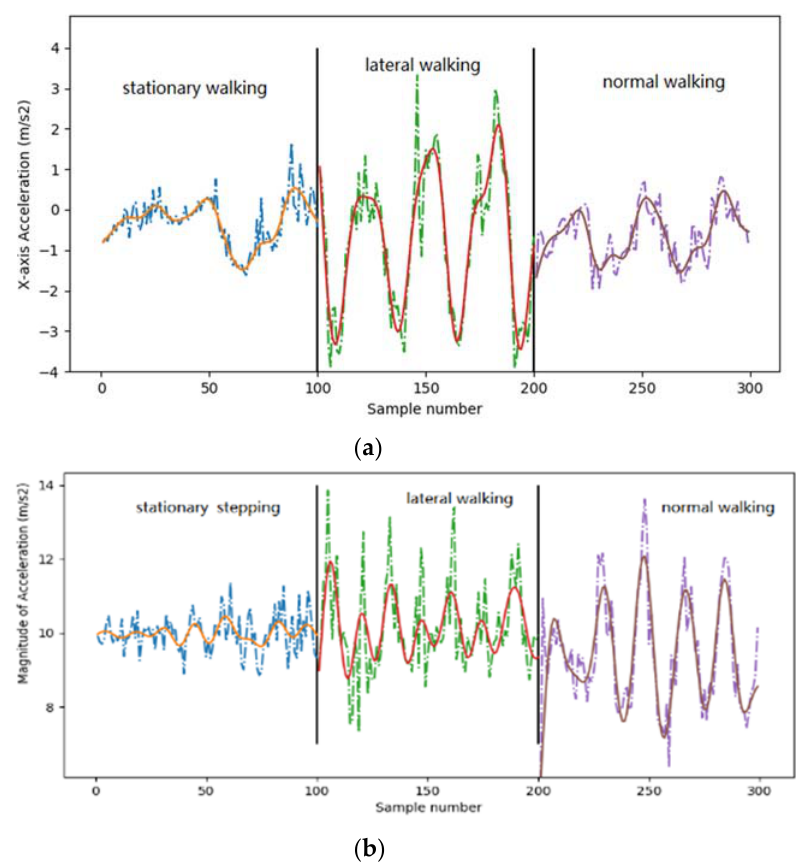
Figure 3. ( a ) The change of X -axis acceleration and ( b ) the magnitude of combined acceleration for stationary stepping, lateral walking, and normal walking (sampling frequency: 50 Hz).